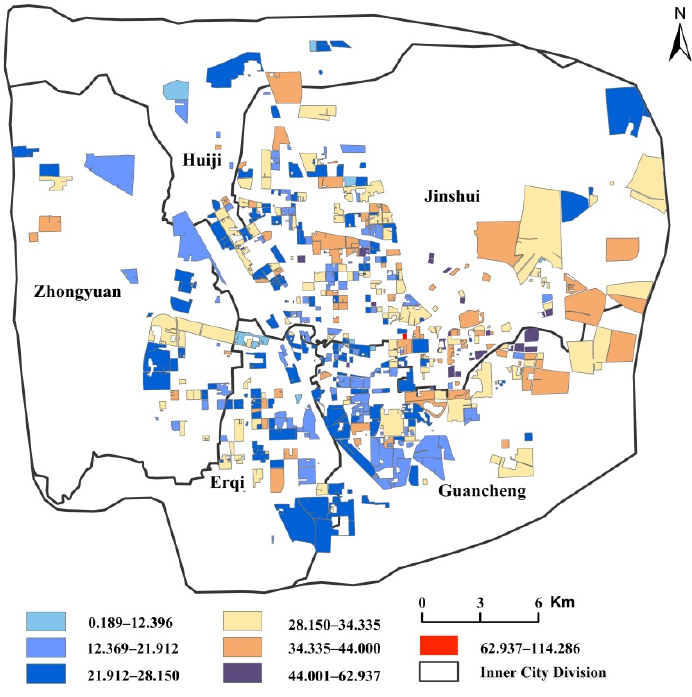
Figure 5. Spatial pattern of rental prices (Yuan/m 2 ). Table 2. Global Moran’s I for the distribution of the GVI values for 5-min, 10-min, 15-min, and 30-min buffer